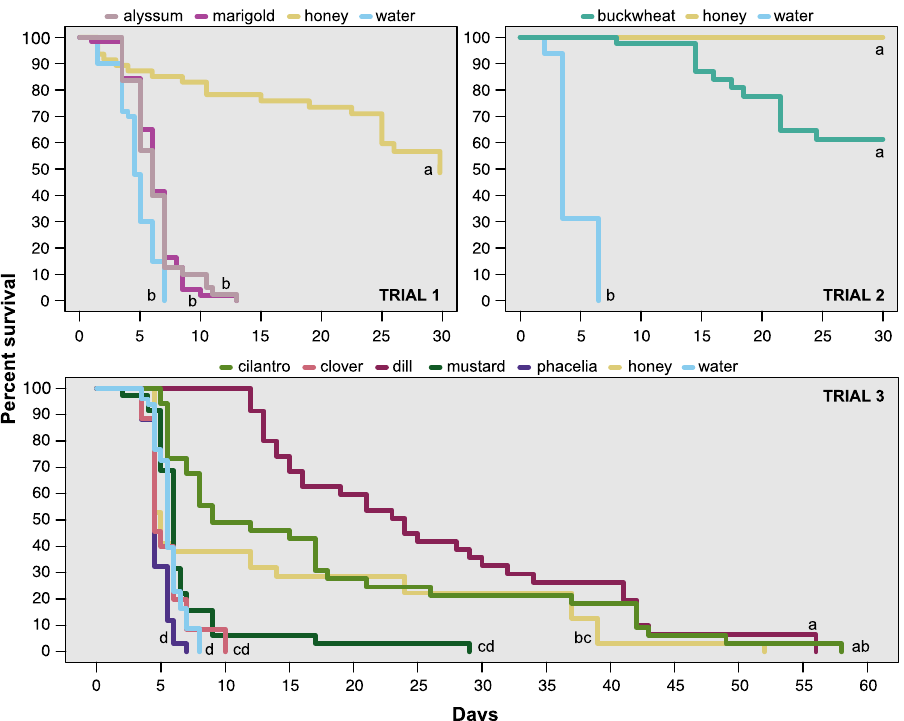
Figure 1. Survival curves of female Trissolcus japonicus fed with flower treatments, honey, or water inside vials in the lab. Per results of log-rank analysis and post-hoc tests, lines with di ff erent letters are significantly di ff erent from each